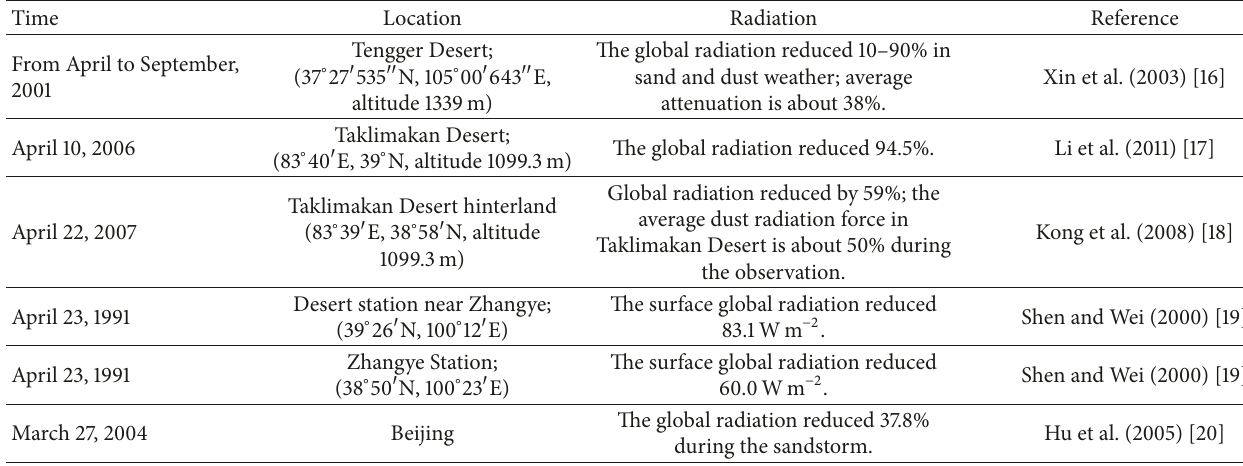
Table 1: The radiation force of aerosols in sandstorms